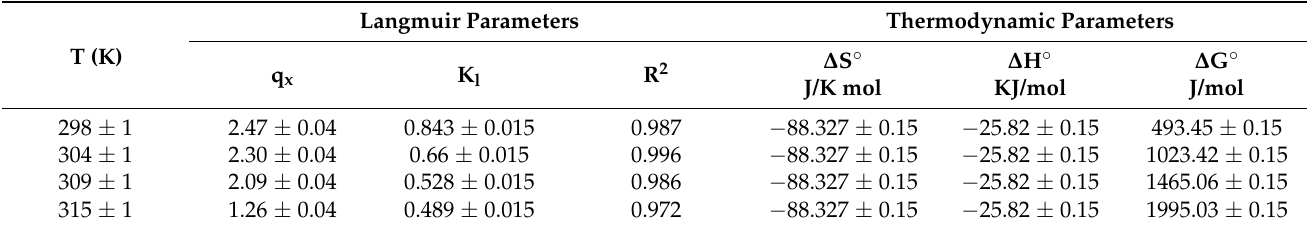
Table 3. Langmuir and thermodynamic parameters for